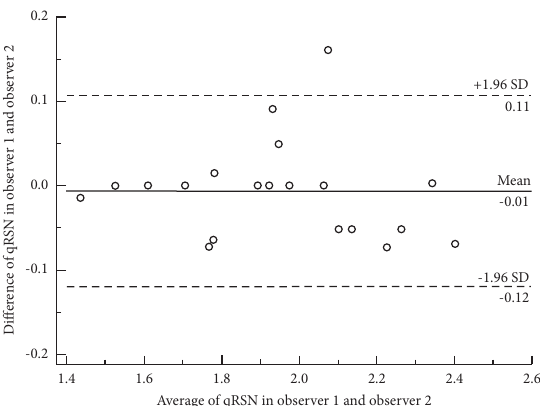
Figure 4: The Bland–Altman diagram of quantitative classification of renal surface nodularity (qRSN). Interrater agreement of qRSN was strong because most of the small circles with interrater differences of qRSN were in the area of 95% limits of agreement. Twenty cases were selected randomly from the full cohort and analyzed for interrater agreement in this study.